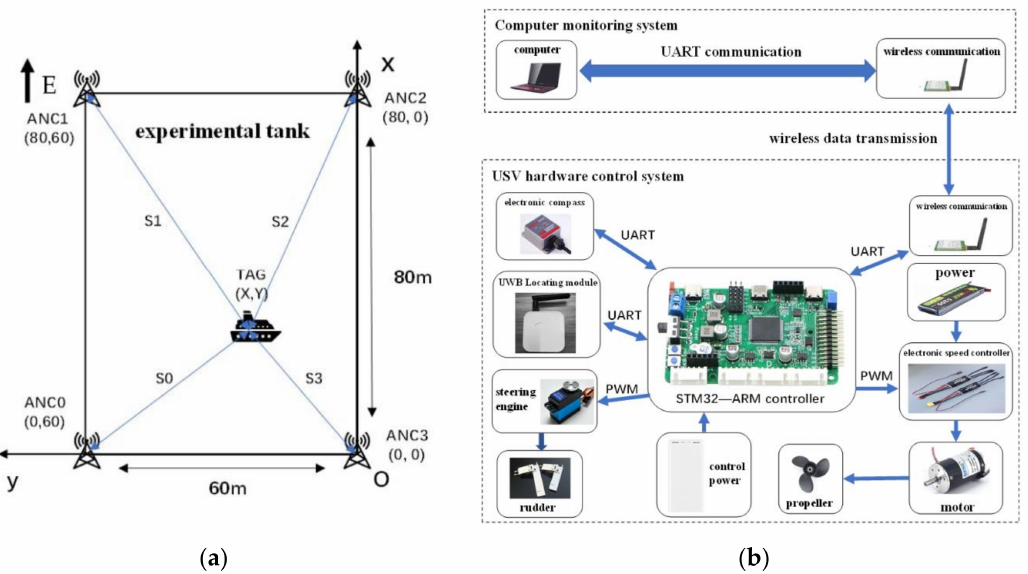
Figure 7. Test Platform Architecture Diagram ( a ) Establishment of the test coordinate system; ( b ) Schematic diagram of data transmission on the hardware platform.